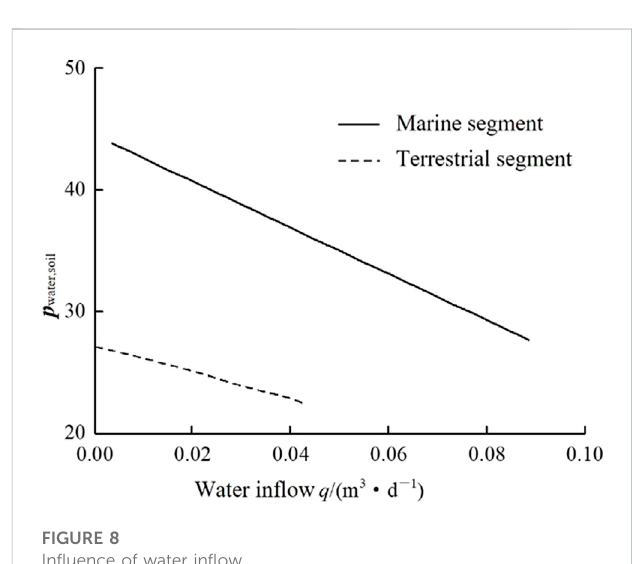
FIGURE 6 The in fl uence of geotechnical gravity.